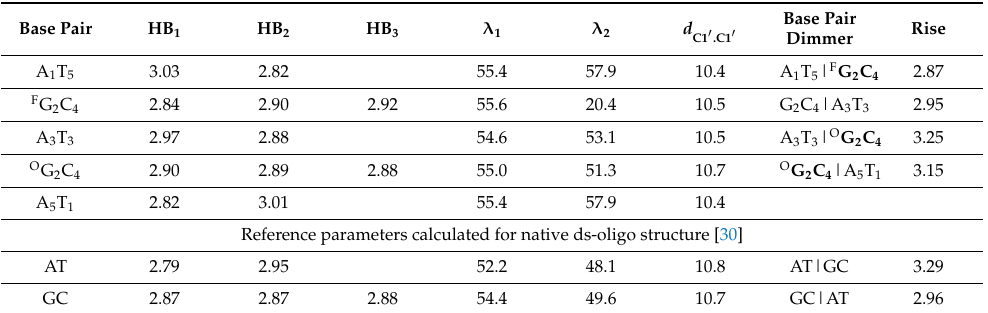
Base Pair Dimmer Rise C1 (cid:48) .C1 (cid:48)